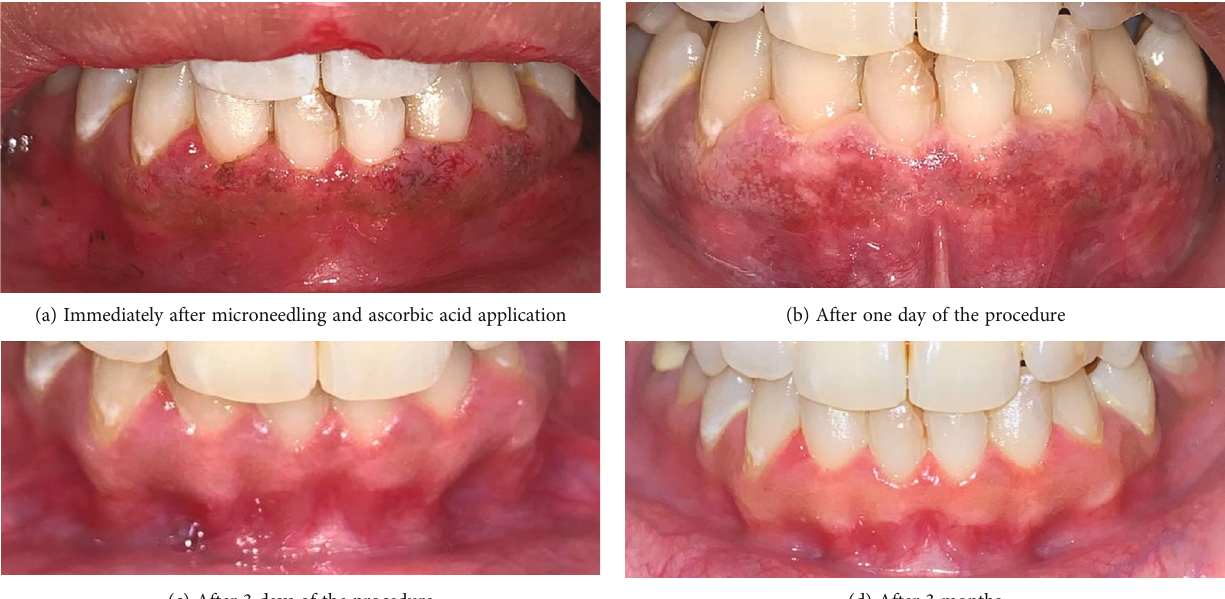
Figure 3: (a – d) Postoperative pictures of gingival depigmentation.